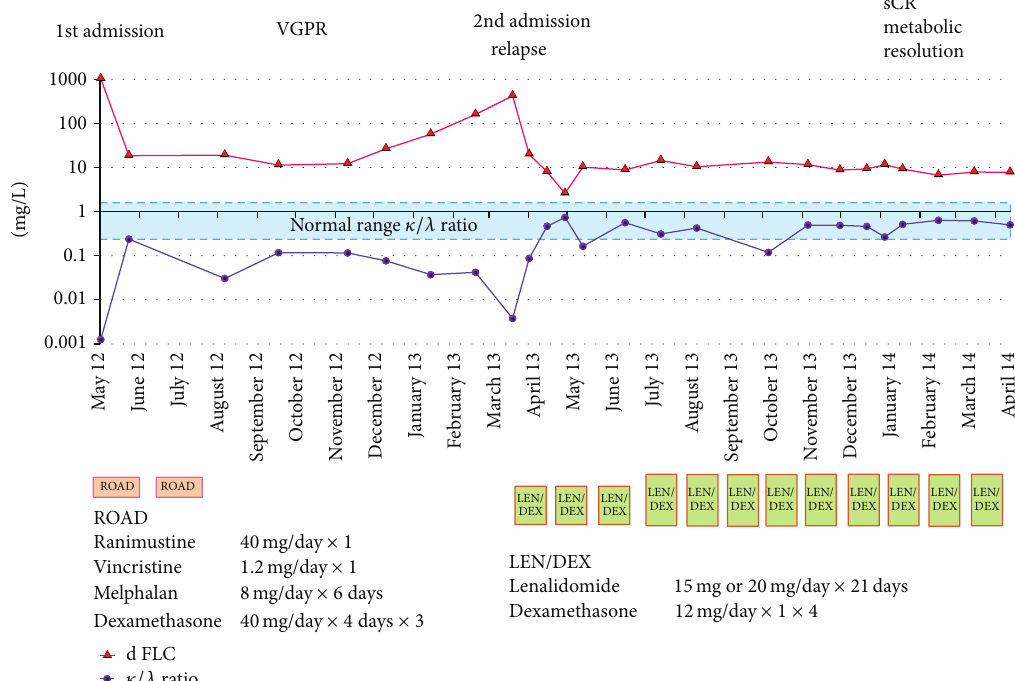
Figure 1: Clinical course of the patient and response to treatment. Difference between involved and uninvolved free light chain (dFLC) and 𝜅 / 𝜆 ratio are reported in the graph alongside the clinical course and treatment regimens.